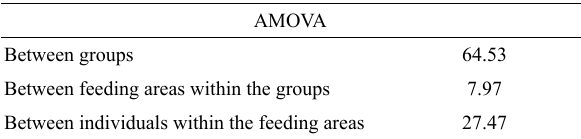
Table 3 ‒ AMOVA values according to the feeding areas described for green sea turtles in the Atlantic Ocean, considering differences between the groups (North and South Atlantic), between feeding areas within the groups and between feeding areas